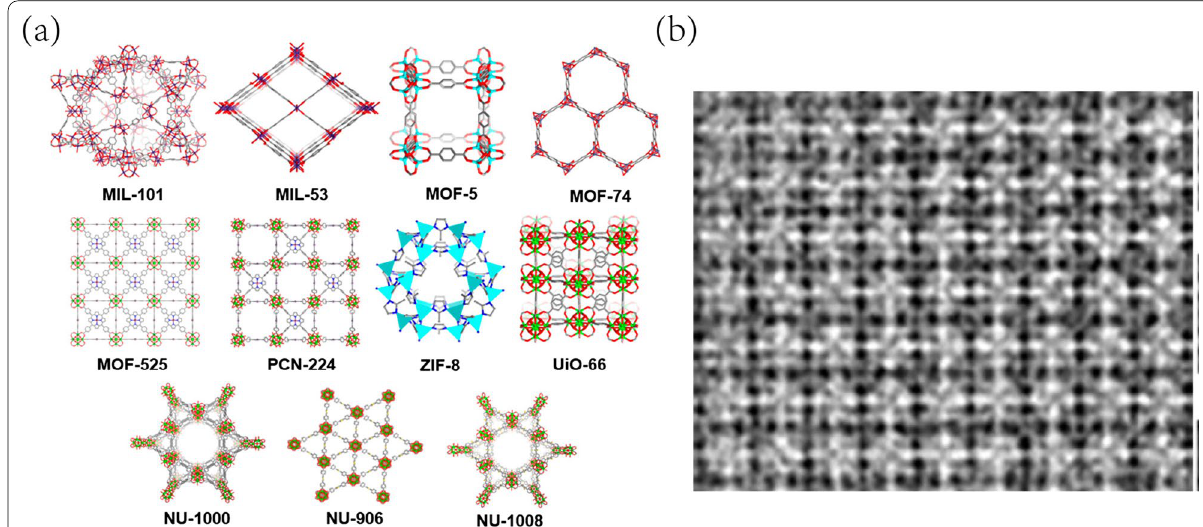
Fig. 3 a Crystal structures of different MOFs. b High resolution TEM image of Uio-66. Referred from [64, 65] with